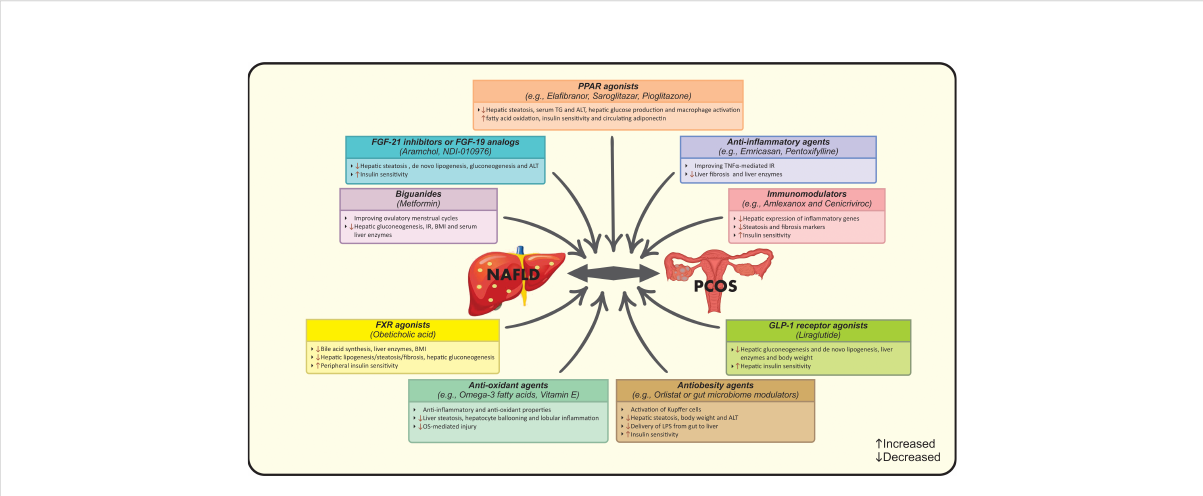
FIGURE 3 Suggested pharmacological treatments for management of NAFLD in PCOS. ALT, Alanine transaminase; BMI, Body mass index; FGF, Fibroblast growth factor; FXR, Farnesoid X receptor; GLP-1, Glucagon-like peptide 1; IR, Insulin resistance; LPS, Lipopolysaccharides; NAFLD, Nonalcoholic fatty liver disease; OS, Oxidative stress; PCOS, Polycystic ovarian syndrome; PPAR, Peroxisome proliferator-activated receptor; TG, Triglycerides; TNF a , Tumor necrosis